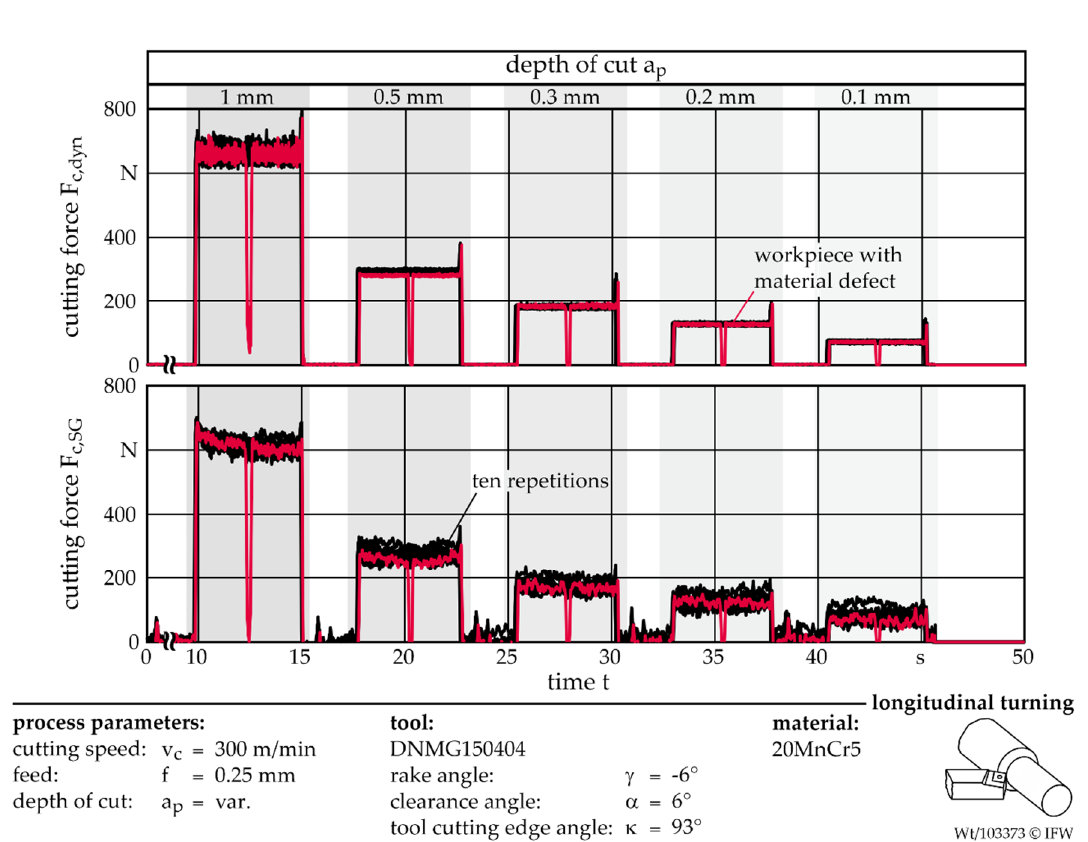
Figure 3. Longitudinal turning with and without a material defect for different depths of the cut.